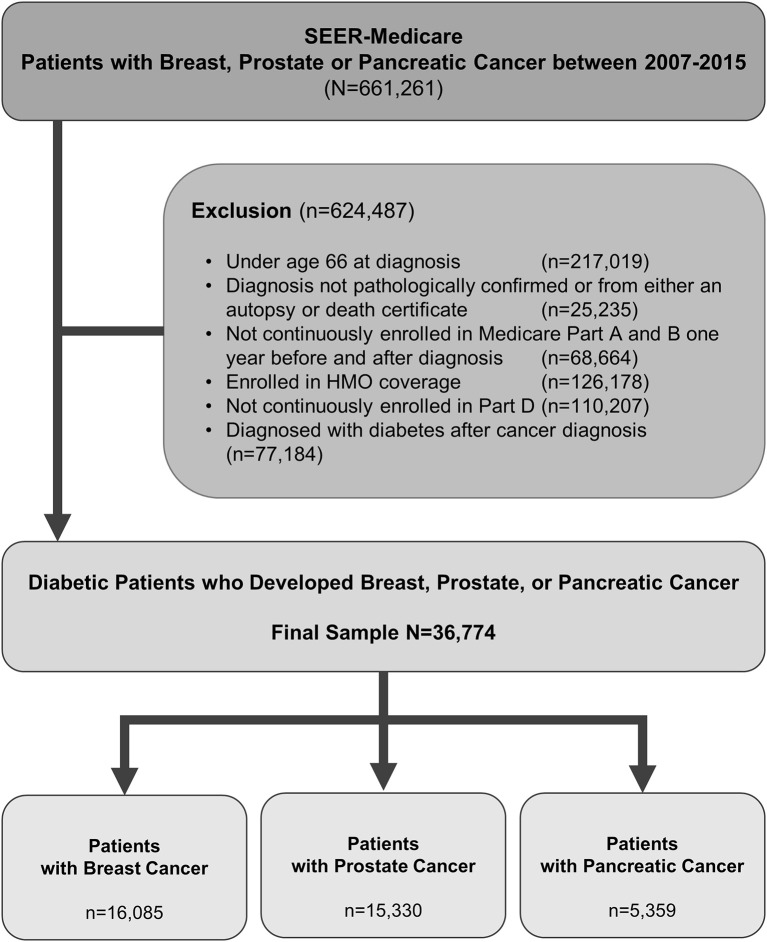
Criteria used and flow chart of patient selection with prostate, pancreas, or breast cancer.